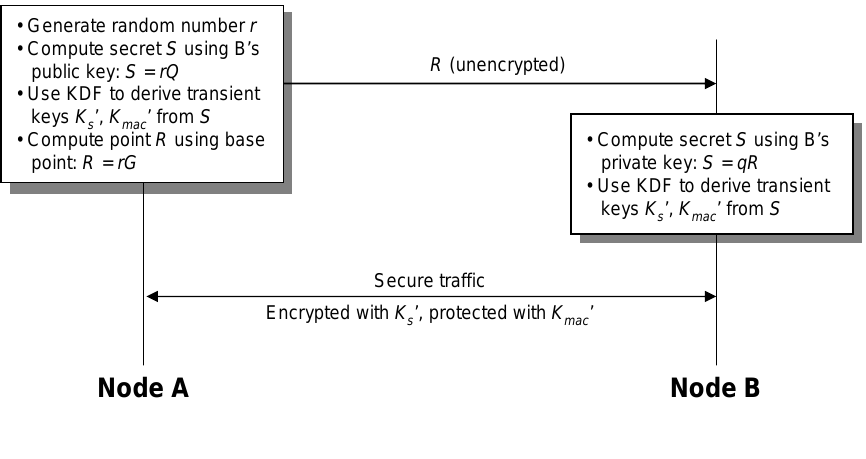
Figure 5. The elliptic curve integrated encryption scheme